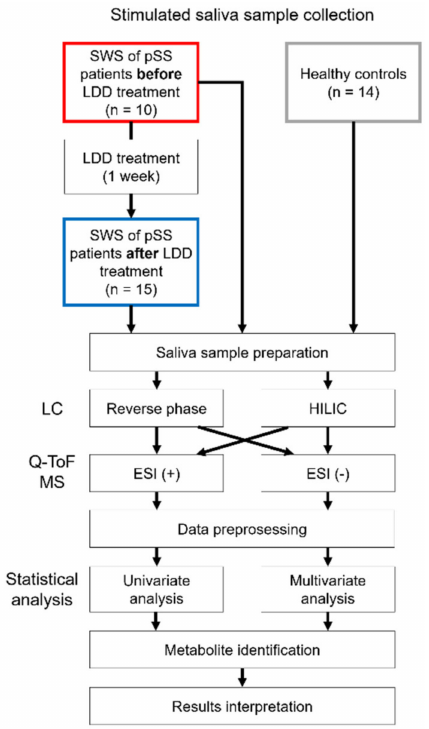
Figure 3. Workflow of the non-targeted metabolomics analysis. Stimulated whole saliva (SWS) samples were collected from patients with primary Sjögren’s syndrome (pSS) before and after low- dose doxycycline (LDD) treatment (20 mg twice per day for one week) and from healthy controls. Saliva samples with low quantity or low quality were removed from the analysis. Details of the non-targeted metabolomics analysis of saliva samples has been previously described [32]. Briefly, after sample preparation, the samples were analyzed with four different analytical methods: using both reverse phase and hydrophilic interaction (HILIC) liquid chromatography (LC) separation, followed with both positive and negative electrospray ionization (ESI). After data preprocessing, we used both multivariate and univariate statistical methods to identify molecular features of interest, from which identification of metabolites was undertaken using both in-house and publicly available